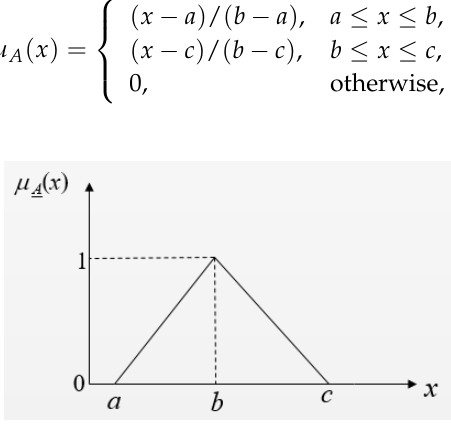
Figure 3. A triangular fuzzy number.